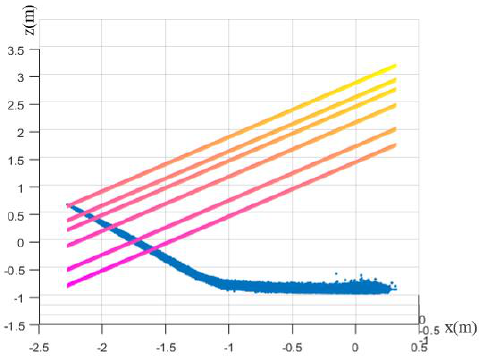
Figure 10. The schematic diagram between different target surfaces. With SMD as the standard, the atomization particle size of simulation at 18 cm was fitted with experimental data, and the data at 30 cm were verified. The horizontal coordi- nates refer to the test data at 18 cm, and the vertical coordinates refer to the simulation data. Cubic polynomial fitting was adopted, and the results are shown in Figure 11.